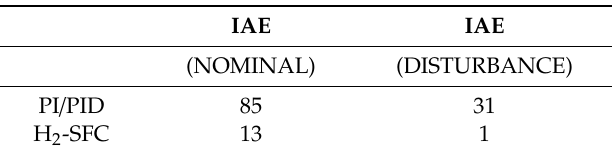
Table 3. Second performance index, integral absolute error (IAE) in the presence of external disturbances of the PI/PID and H 2 -SFC controllers.